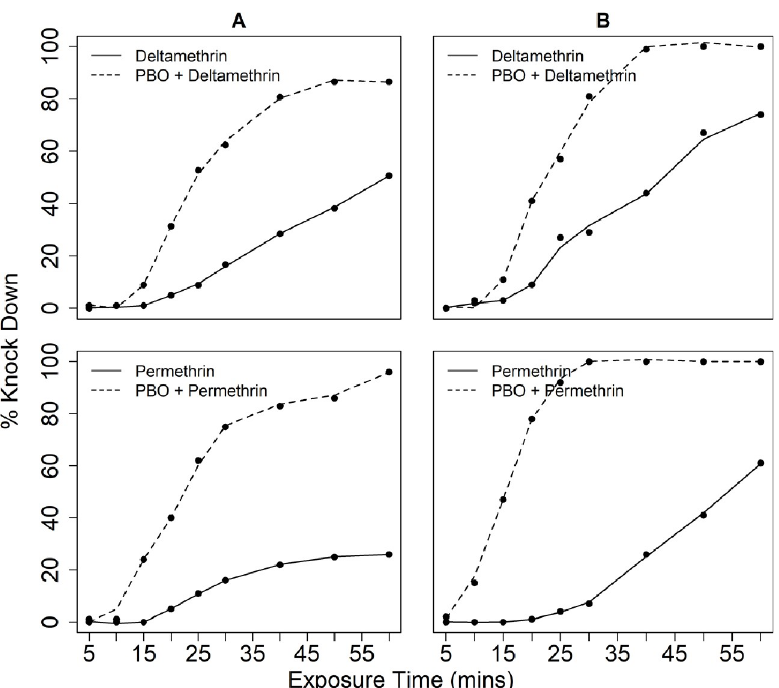
Fig 7. Knockdown time responses of resistant: A. An . arab iensis colony population and B. An . arabiensis wild population to 0.05% Deltamethrin and 0.75% Permethrin.